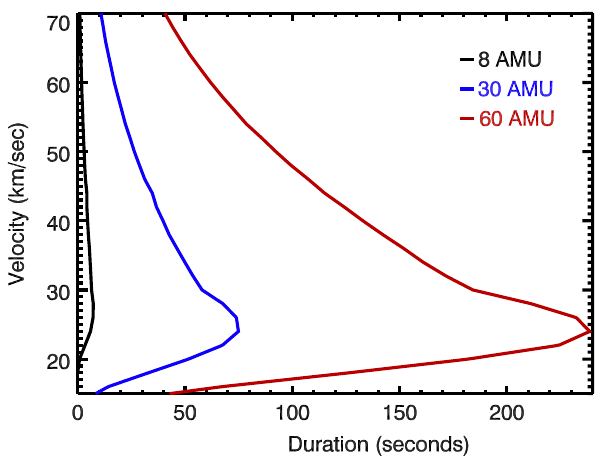
Fig. 3. The duration of 3 meteor trails of different atomic masses: 8, 30 and 60AMU (representative of Oxygen, Chondrite and Iron compositions, respectively) for a variety of entry velocities. The duration of a meteor trail is plotted in seconds and the meteors’ velocities in kms − 1 for a 10.0µg particle entering with 0 ◦ entry angle with a background wind speed of 10ms − 1